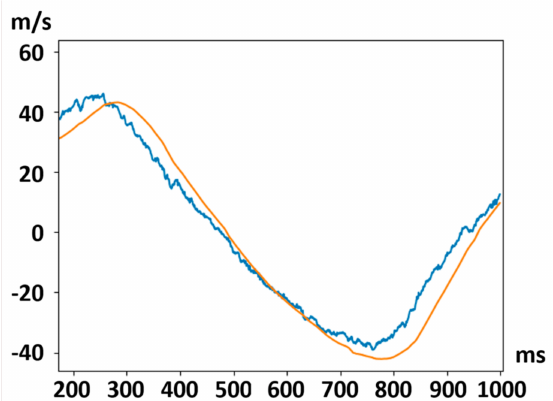
Figure 14. Output response of single-layer EKF with actually swaying within ± 40 degrees.